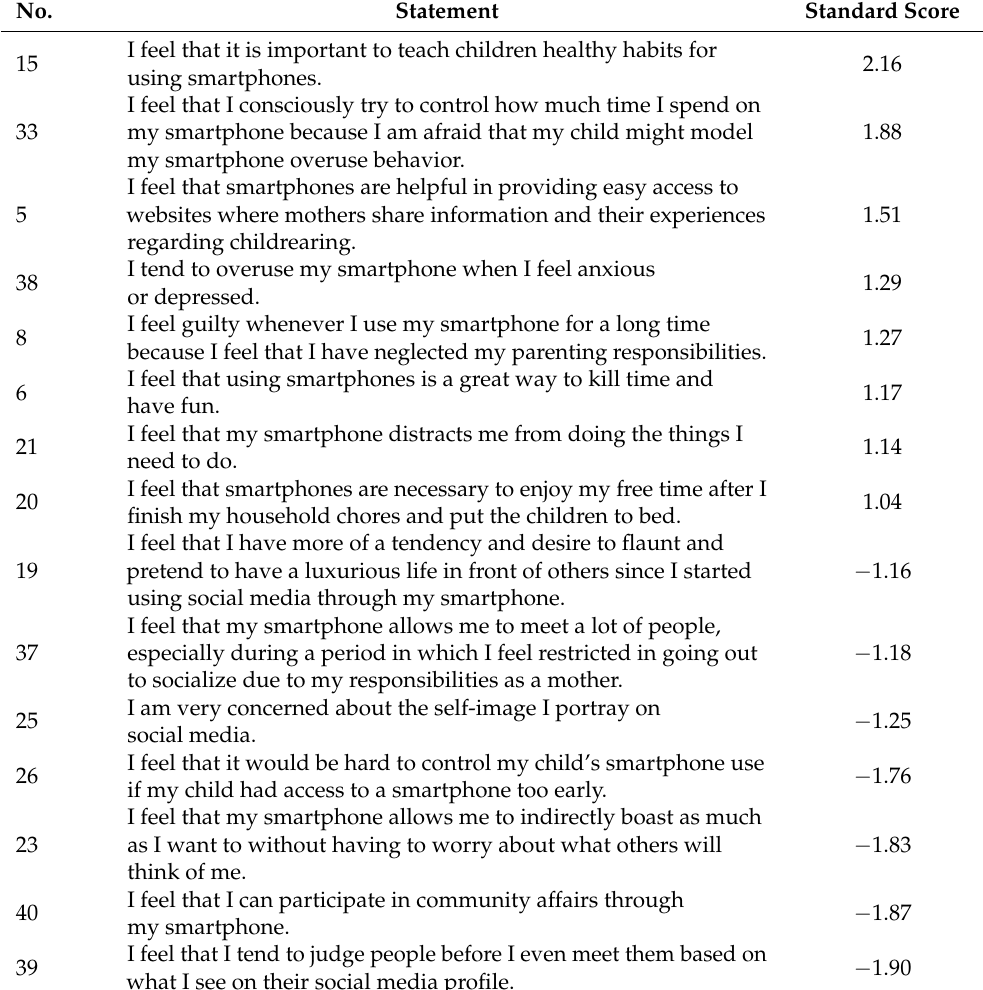
Table 5. Statements and standard scores for Type 3 ( ≥±